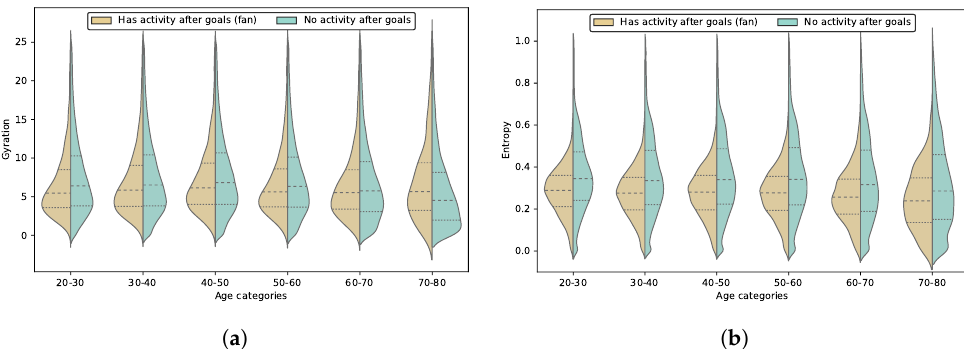
Figure 16. Radius of Gyration ( a ) and Entropy ( b ) distributions in different age categories, comparing the fans who had activity right after any two of the Hungarian goals and the rest of the SIM cards.